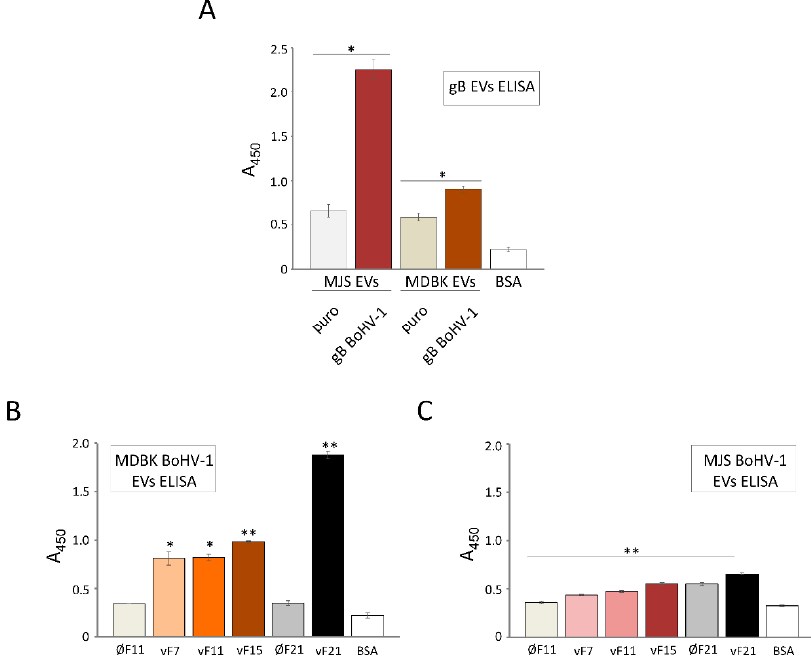
Figure 8. EVs-transferred BoHV-1 proteins or specifically gB can bind virus-specific antibodies from the whole virus-specific animal serum. ( A ) EVs gB ELISA was performed with the goat anti-BoHV-1 serum.. The signal from gB-containing EVs was compared with the signal from MJS/MDBKpuro. ( B ) and ( C ) ELISA detection of BoHV-1 proteins in OptiPrep-isolated material (fractions vF11, vF15 and vF21) from BoHV-1-infected MDBK ( B ) or MJS ( C ) cells. The signal from virus-infected material was compared with the signal from the corresponding fractions F11 or F21 from uninfected MJS/MDBK (designated as Ø). A total of 1% BSA in PBS served as a background control. Each reaction was performed in triplicate and bars represent means of absorbance at 450 nm with the standard deviations; * p ≤ 0.01, ** p ≤ 0.001.